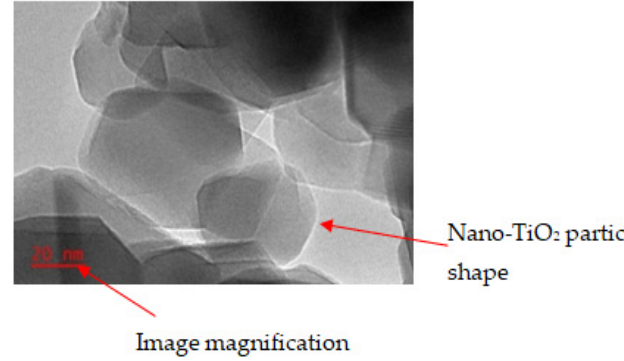
Figure 8. TEM images of the obtained rutile-TiO 2 NPs.